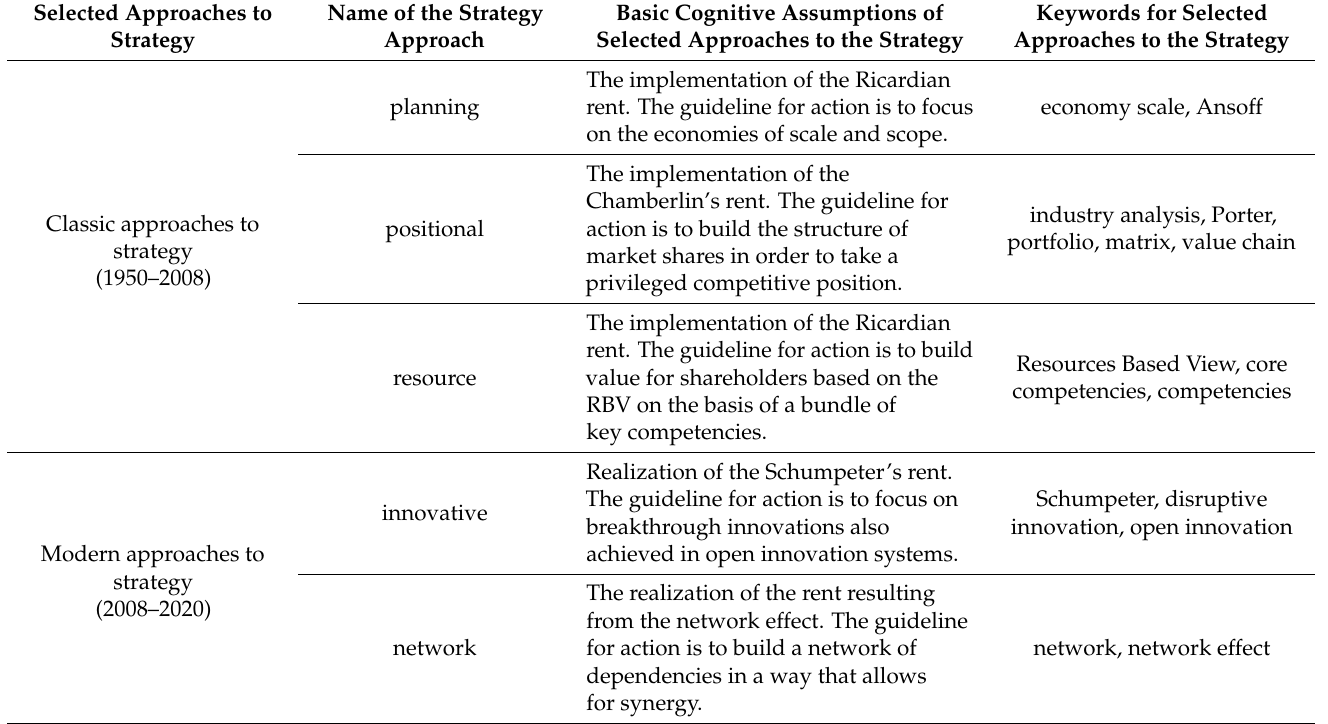
Table 1. Cognitive premises of approaches to strategy selected for the